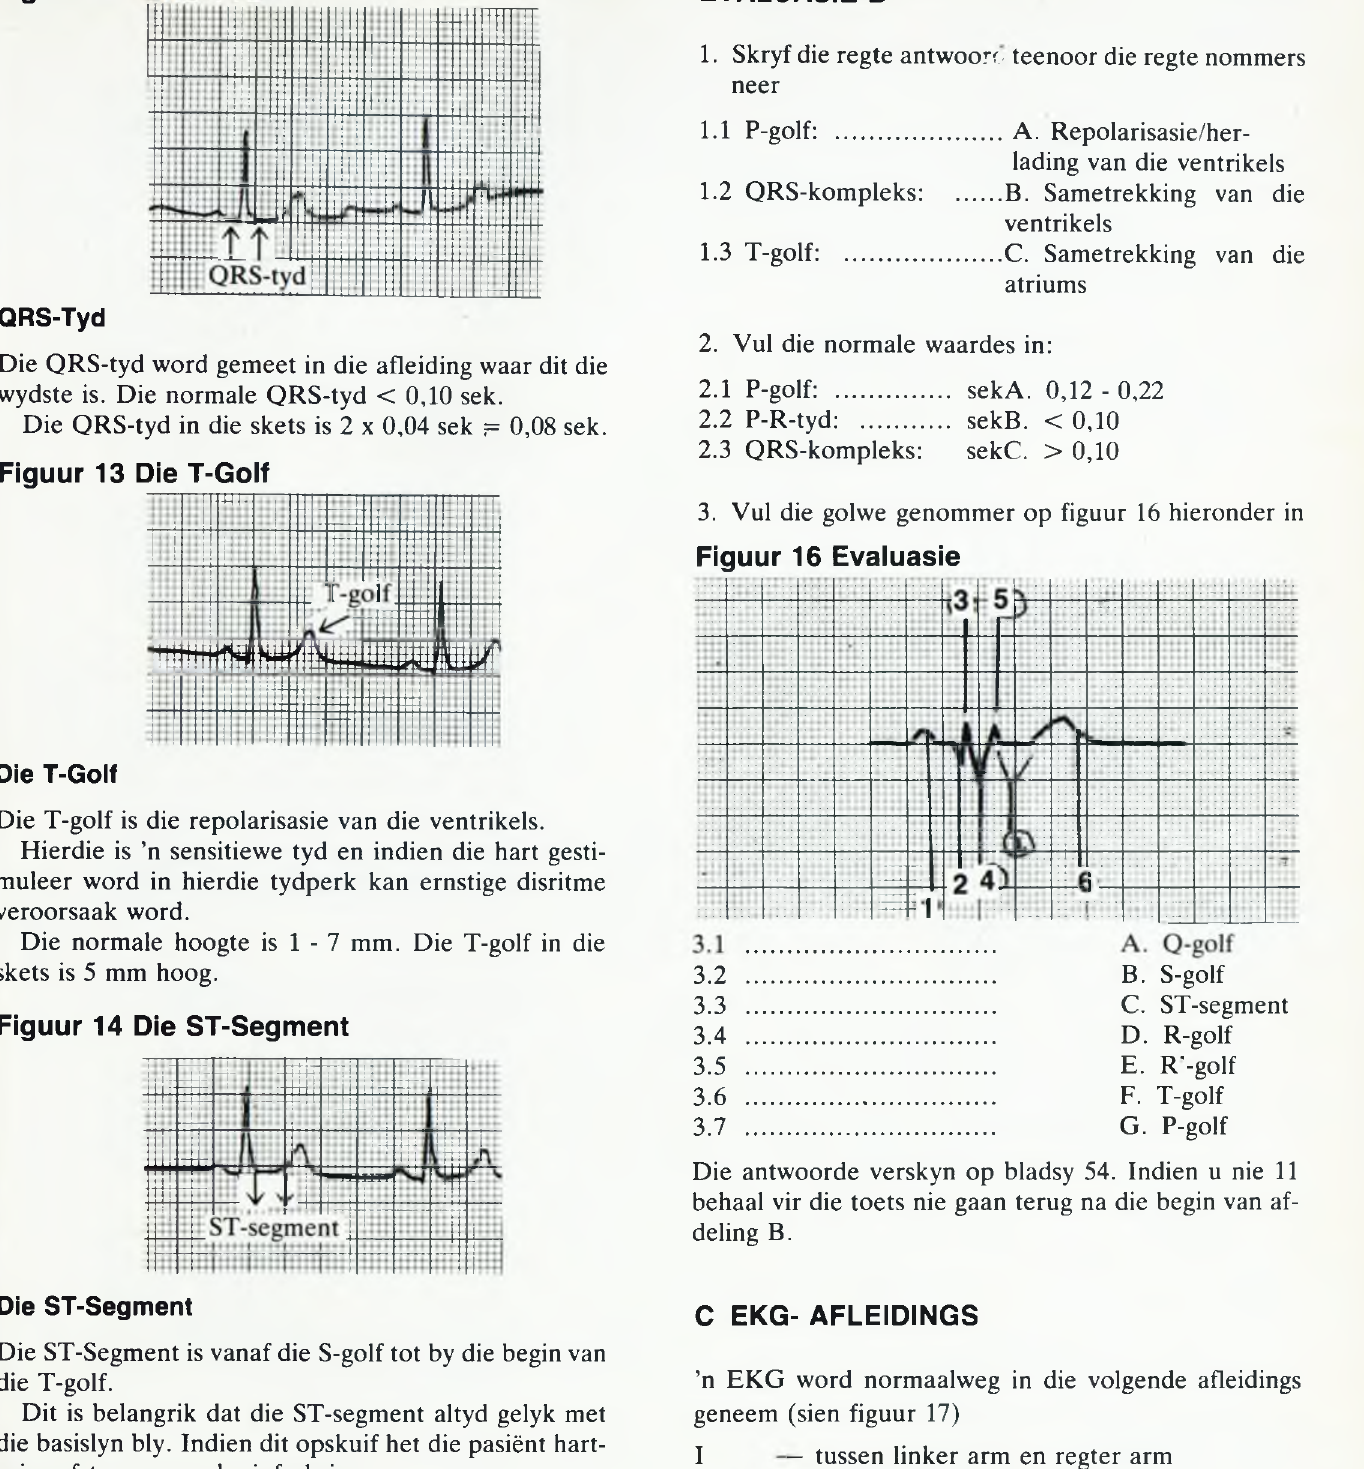
Figuur 15 QT-Tyd